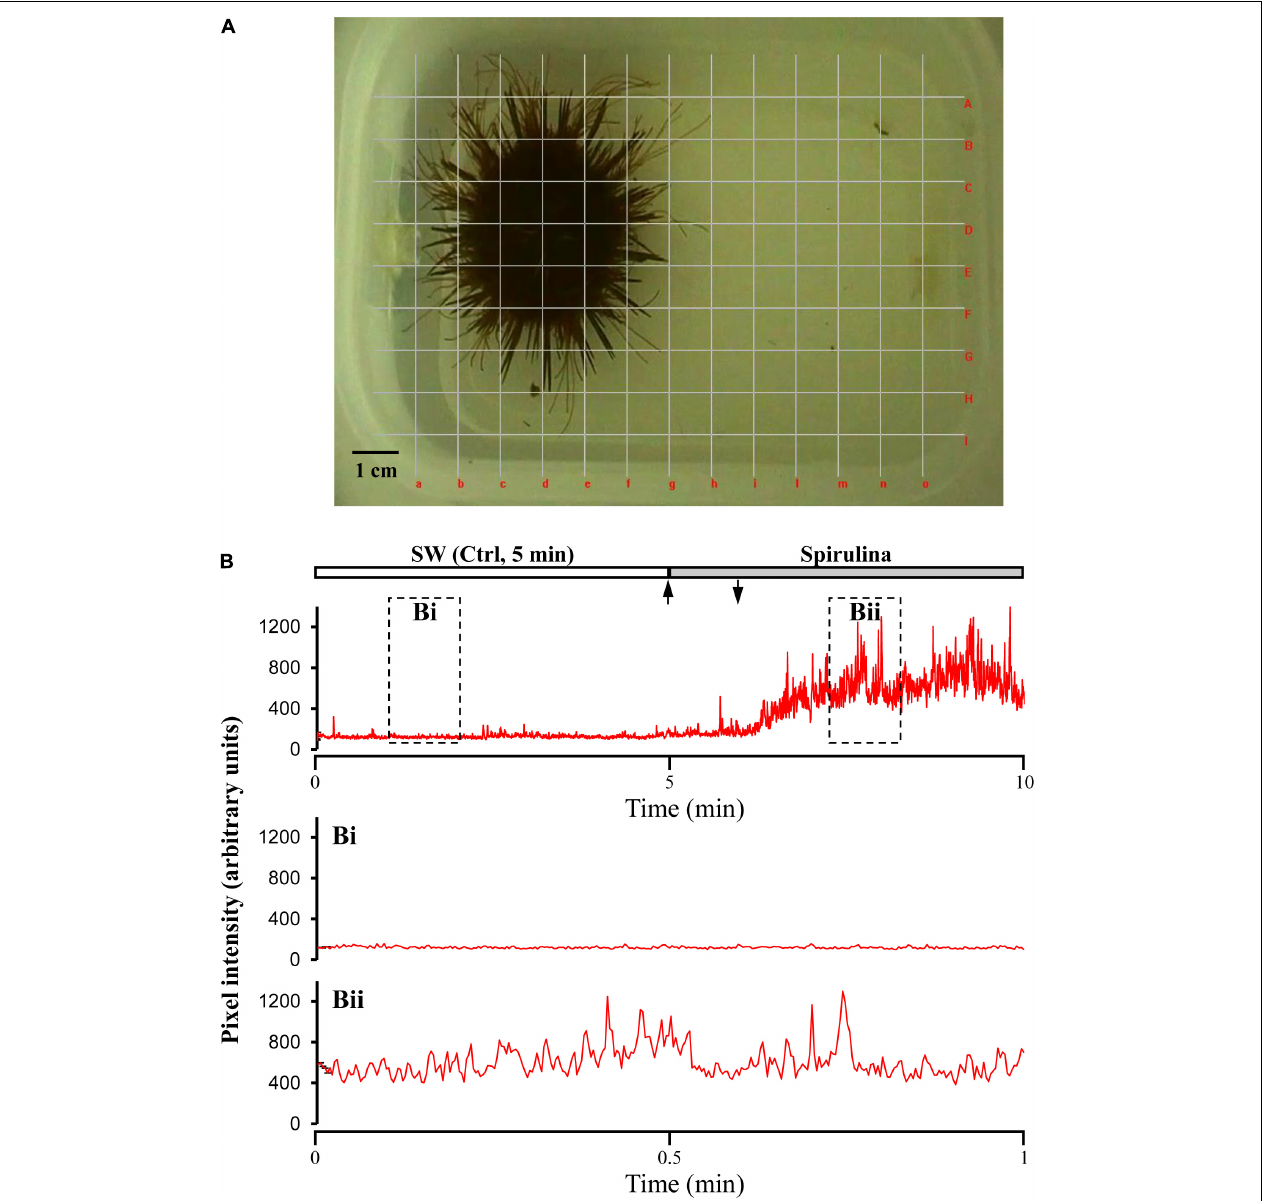
FIGURE 1 | Recording layout of the sea urchin movements. (A) Video photogram showing the experimental tank with the superimposed grid, composed by 13 vertical (a–o) + 9 horizontal (A–I) evenly spaced lines, used to cover the entire area of sea urchin activity. (B) Sample recording of an “urchinogram,” comprising all summated visible movements of spines, pedicellariae, tube feet, and eventually of the whole sea urchin, in response to the blue-green algae Spirulina. Movements were estimated by changes in the mean squared difference in light intensity between successive frames determined by means of the Aviline software analysis (Data were recorded at 5 frames/s). Arrows indicate the time of stimulus supply. Bi and Bii represent the two enlarged portions of the recording within the dashed